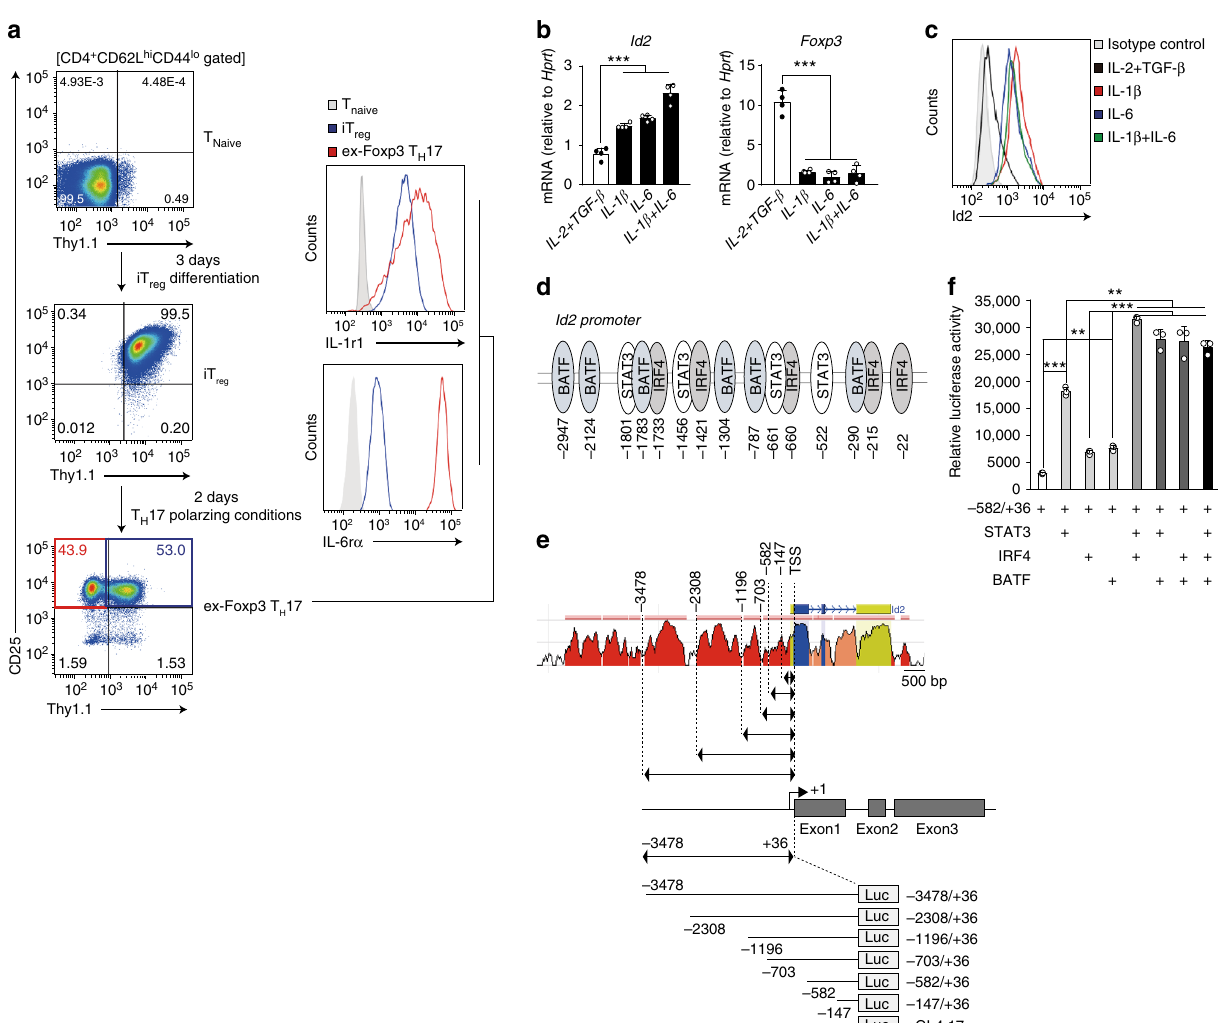
Fig. 5 Id2 is induced by IL-1 β and IL-6 mediated signaling and downstream transcription factors STAT3, IRF4 and BATF in T reg cells. a Strategy for sorting T Naive , iT reg , and ex-Foxp3 T H 17 cells from Foxp3 Thy1.1 reporter mice (left). Flow cytometry analysis of IL-1r1 and IL-6r α among the T Naive , iT reg , and ex-Foxp3 T H 17 cells (right). b , c FACS-sorted iT reg cells were re-stimulated with cytokines as indicated and analyzed for Id2 and Foxp3 mRNA expression by RT-qPCR ( b ) as well as for Id2 protein levels by fl ow cytometry ( c ). d Cartoon depicting highly putative STAT3, IRF4, and BATF binding motifs upstream of Id2 transcription start site (TSS). e Cartoon depicting Id2 promoter constructs used for luciferase reporter assay. f Id2 promoter-luciferase construct ( − 582/ + 36) were co-transfected with the combination of STAT3, IRF4 and BATF expressing vectors in HEK-293 T cells. Lysates were prepared 30 h after transfection, and luciferase activities were measured with the reporter activities normalized to renilla luciferase activity. *P < 0.05, **P < 0.005, ***P < 0.001 (Student ’ s t -test). All data are representative three independent experiments with similar results (error bars,